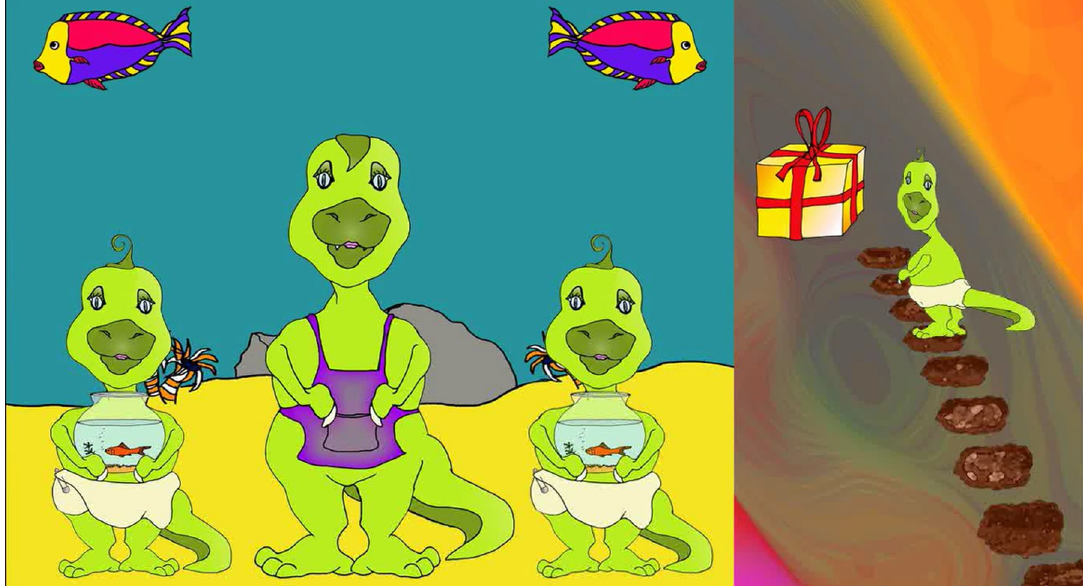
Fig 1. Screenshot of an experimental trial in the XAB